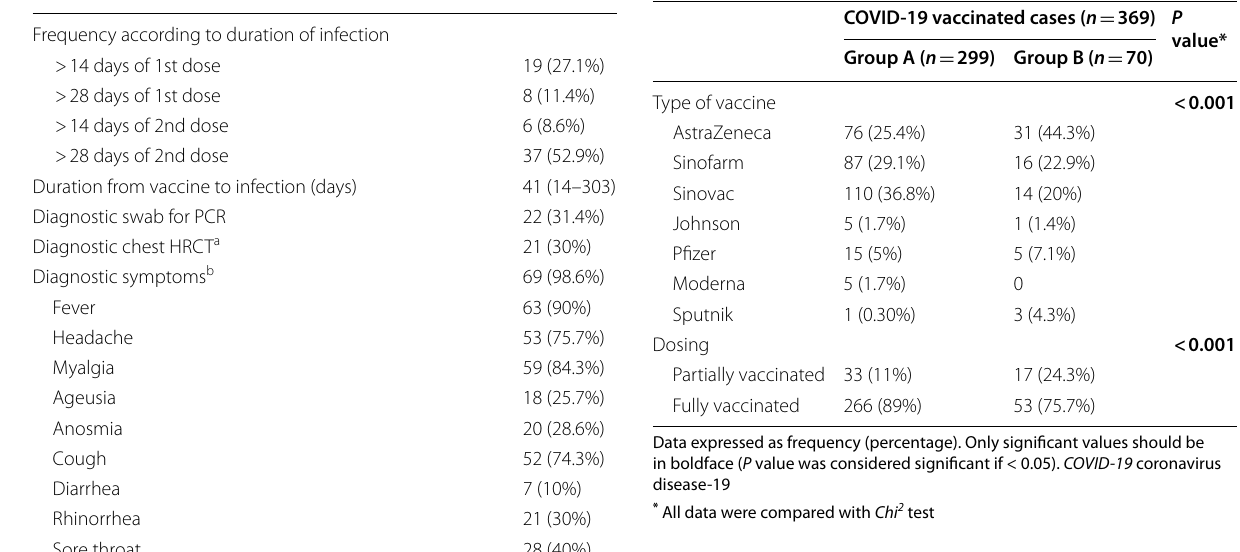
Table 6 Type of vaccine and doses used among patients developed post-vaccine COVID-19 infection (group B) versus vaccinated participants who did not develop infection group A